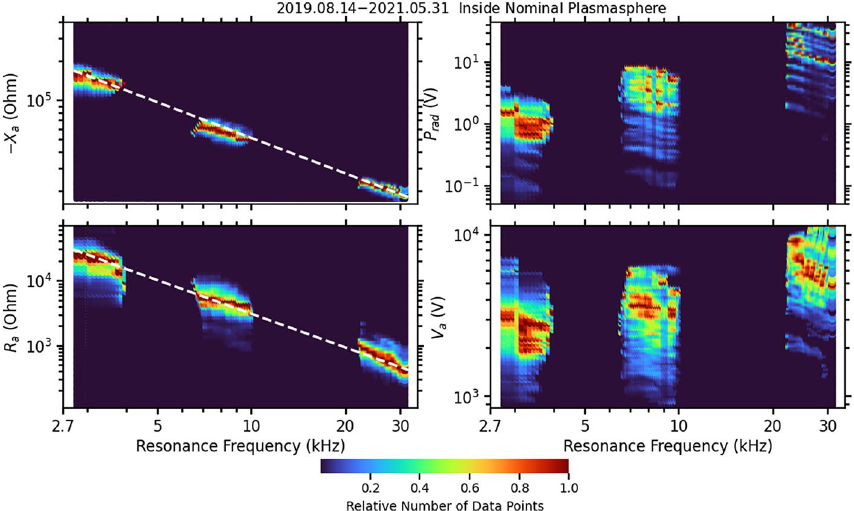
Figure 1. Antenna reactance – X a (upper-left), antenna resistance R a (lower-left), antenna power output, P out , (upper-right), and the antenna voltage, V a , (lower-right). The measurement data are grouped according to the resonance frequency into frequency bins of 100 Hz wide. The data within each frequency bin are divided according to their logarithmical value of the vertical quantity into 80 cells. The color-coding denotes the number of data points within a cell divided by the maximum number of data points in any single frequency bin. The total number of data points is about 142,700. The dashed lines in the left two panels show the best fit to a power- law